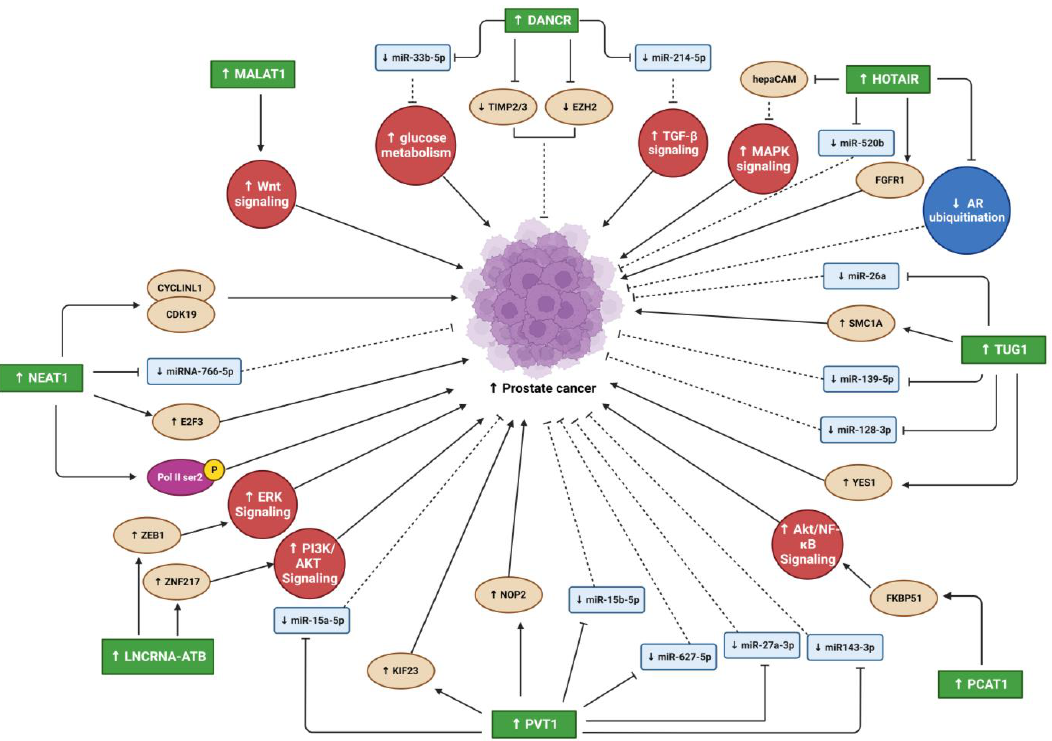
Figure 2. Summary of lncRNAs oncogenic effects that promote PC progression. Blunt arrows ( ⊥ ) indicate inhibition while sharp arrows ( → ) indicate stimulation. Solid lines denoted direct interaction; interrupted lines denoted indirect interaction.